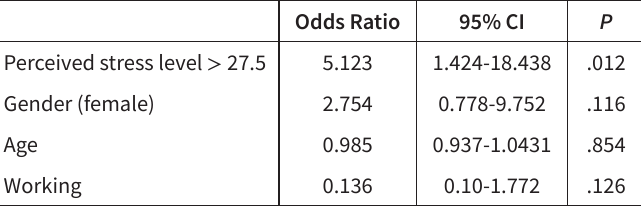
Table 4. Logistic Regression Analysis Was Performed to